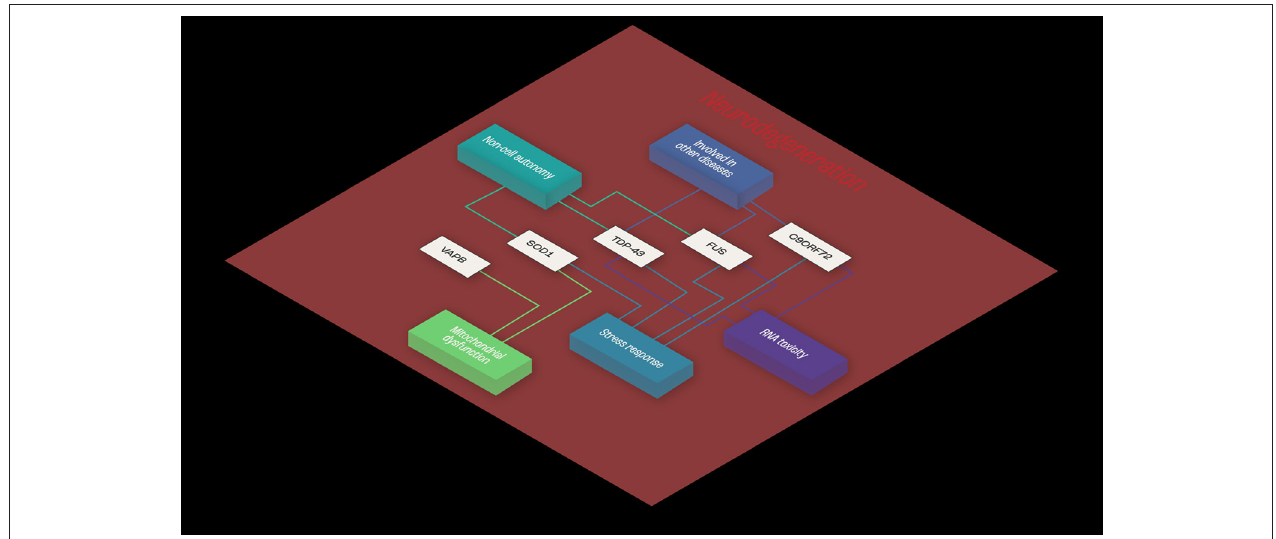
FIGURE 1 | Example of functional interaction, and co-dependence. Common shared pathways in ALS, and functional similarities shared between TDP43, SOD-1, and FUS- RNA- and non-RNA-binding proteins. The three proteins appear to share mechanisms related to toxicity mechanisms and RNA toxicity, cellular stress response and mitochondrial impairment and cell autonomy, implying functional synergies in ALS disease pathogenesis.